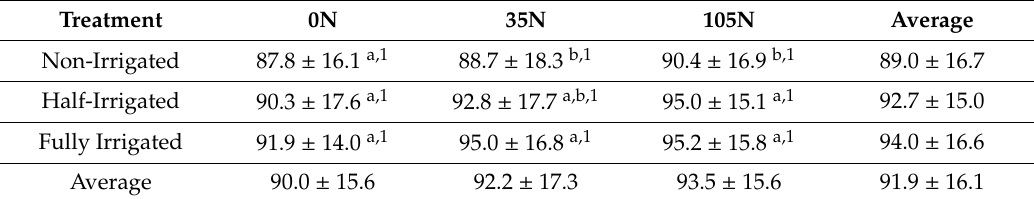
Table 11. The e ff ect of di ff erent fertilization rates on plant height (cm) of soybean (cv. Pannonia Kincse) under di ff erent irrigation regimes, averaged among 2017, 2018, and 2019 in Debrecen,